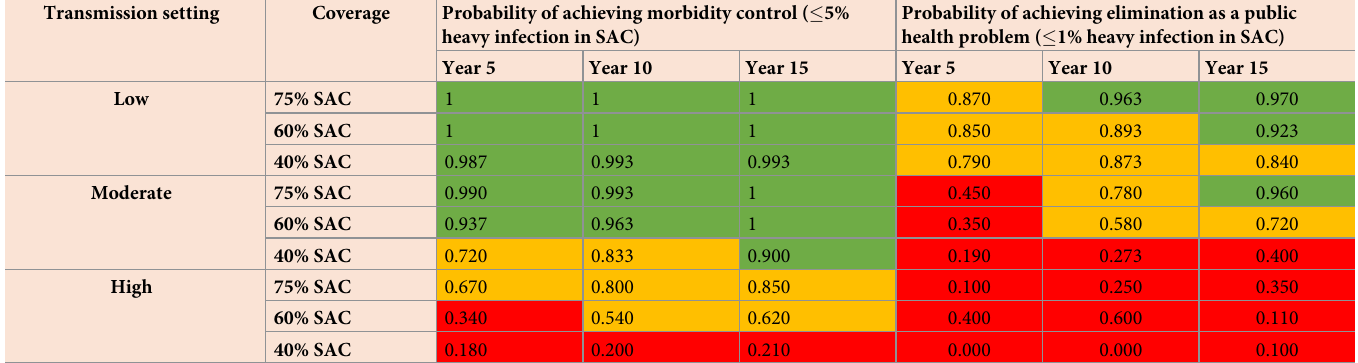
Table 4. Probability of reaching the WHO 5% morbidity control and 1% elimination as a public health problem goals using MDA only, treating once every 3 years in low transmission settings, once every 2 years in moderate transmission settings and once a year in high transmission settings. Green shaded areas = probability of reaching target > 0.9, Yellow shaded areas = 0.5 � probability of reaching target < 0.9, Red shaded areas = probability of reaching target < 0.5. Transmission setting